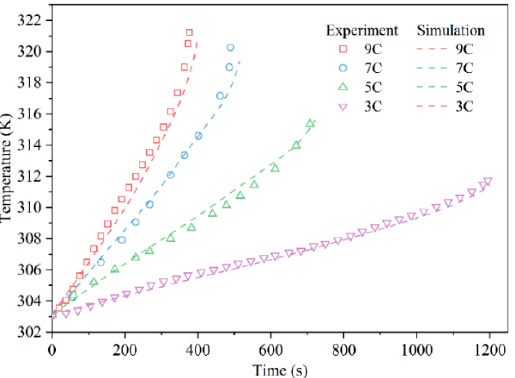
Figure 3. The battery temperature variations from simulation results and experimental data. Reproduced with permission from Elsevier [29].